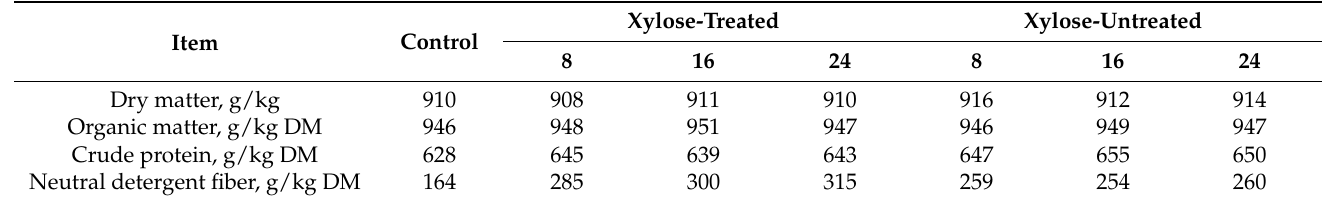
Table 1. Chemical composition of experimental ingredients for Experiment 1—Autoclave.